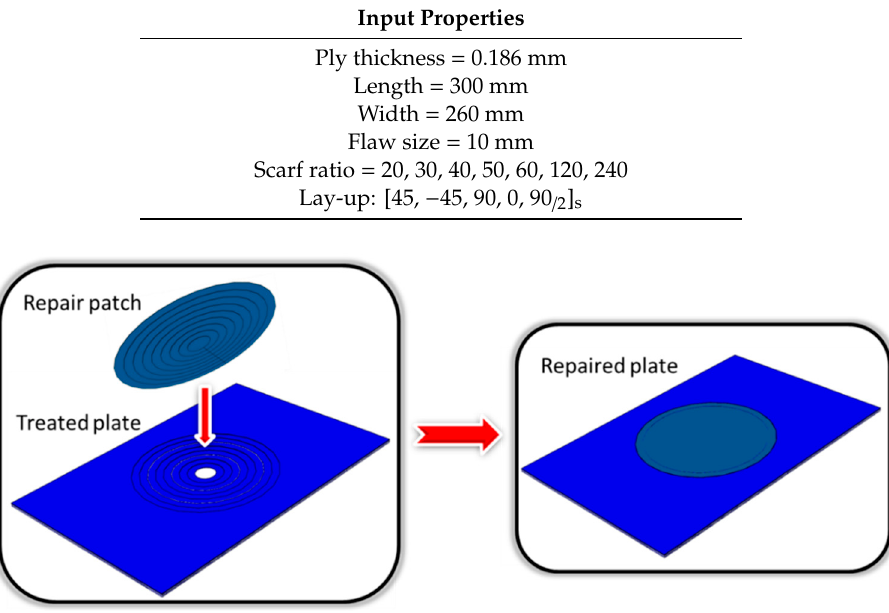
Figure 2. Schematic of patch installation.